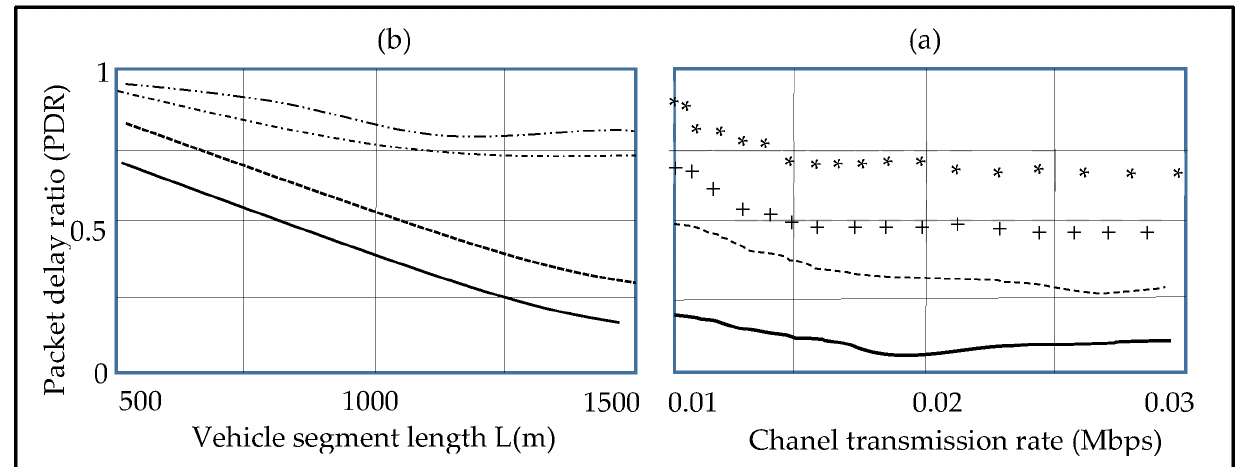
Figure 4. Road segment packet delivery ratio, depends on the channel transmission rate. ( a ) the mean distance between the theoretical and simulation results is only 4.85%, in the case of cs = 0.75 R. Furthermore, as the distance of the road segment increases, so does the ratio of the packets delivered, since more transmission hops are necessary. ( b ) depicts the packet delivery ratio model’s availability with the varied vehicle separation density, packet size, and the channel transmission rate (CTR).